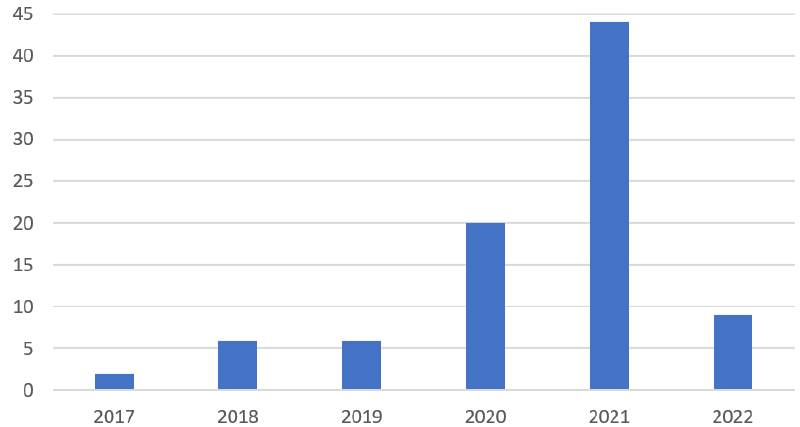
Figure 4. Results distribution by year.